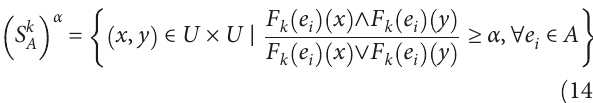
Algorithm 2 (group decision-making based onfuzzy